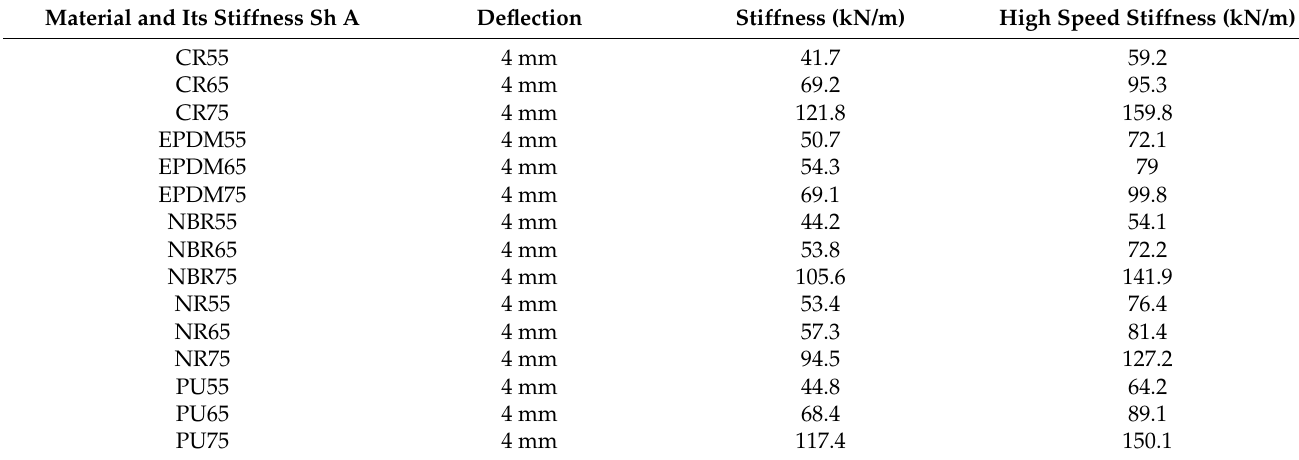
Table 1. Averaged stiffness values of shock absorber for 4 mm and 5 m/s dynamic deflection.